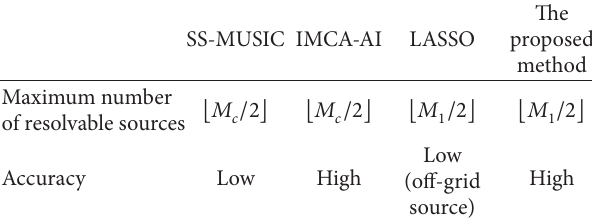
Table 1: Comparison of the four methods for coprime